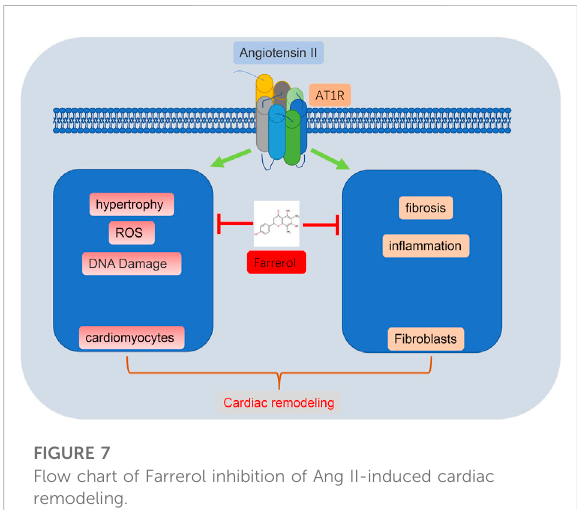
FIGURE 7 Flow chart of Farrerol inhibition of Ang II-induced cardiac